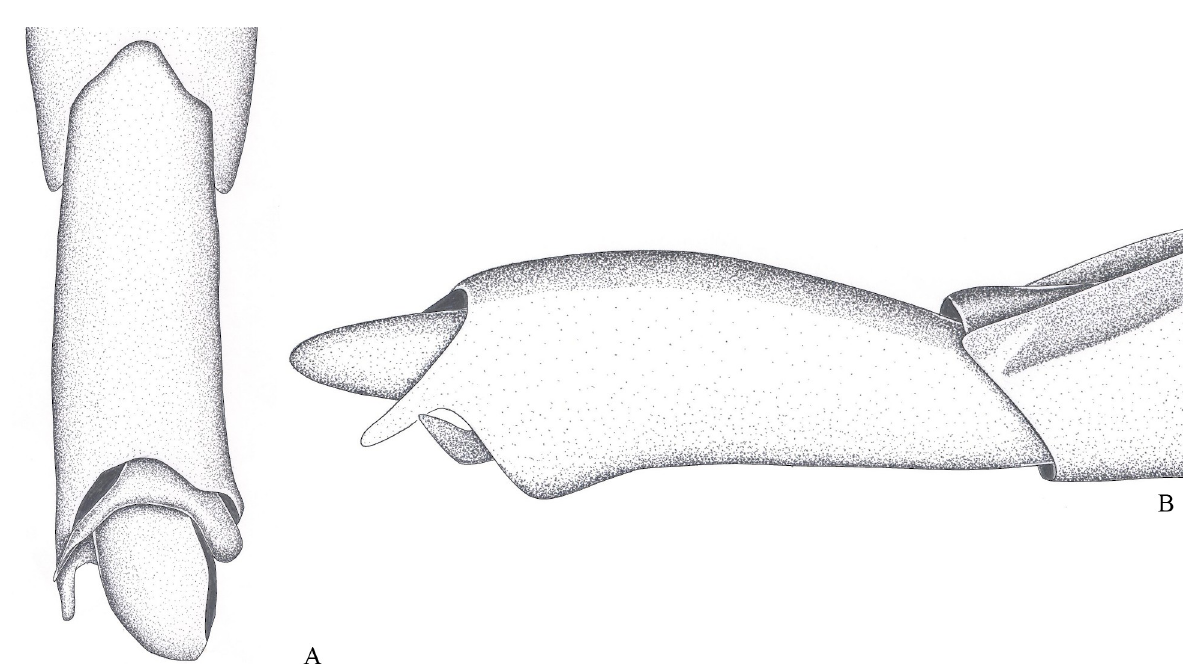
Fig 27. Potamobates vivatus . (A) Male, terminalia, ventral view; (B) male, terminalia, right lateral view.